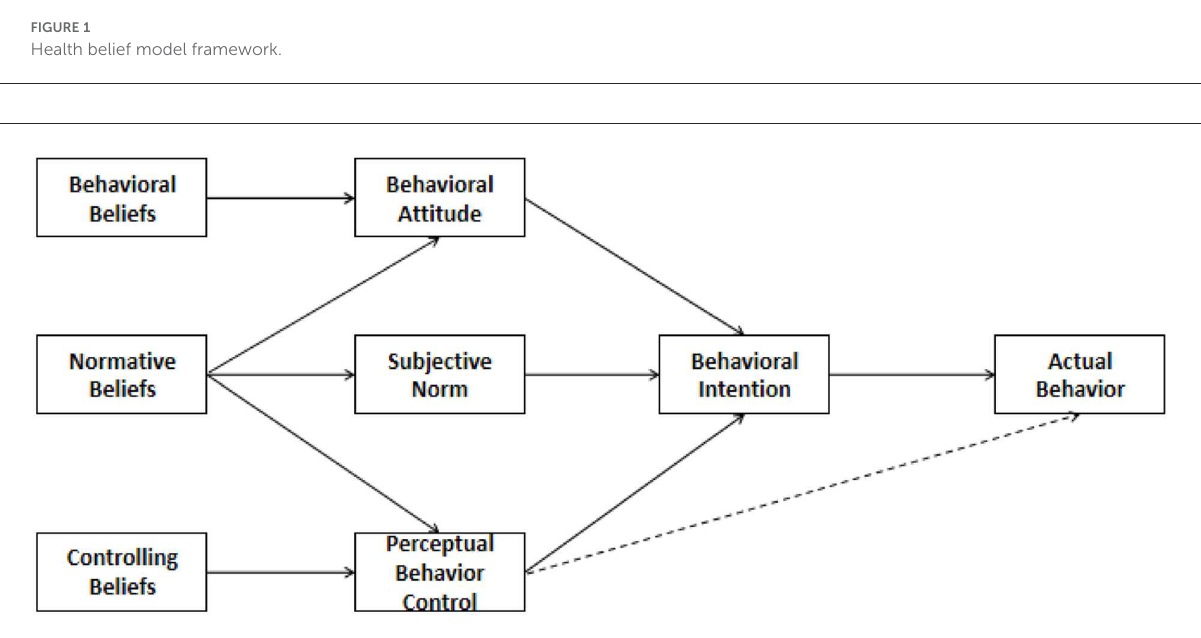
FIGURE2 The theoretical framework of planned